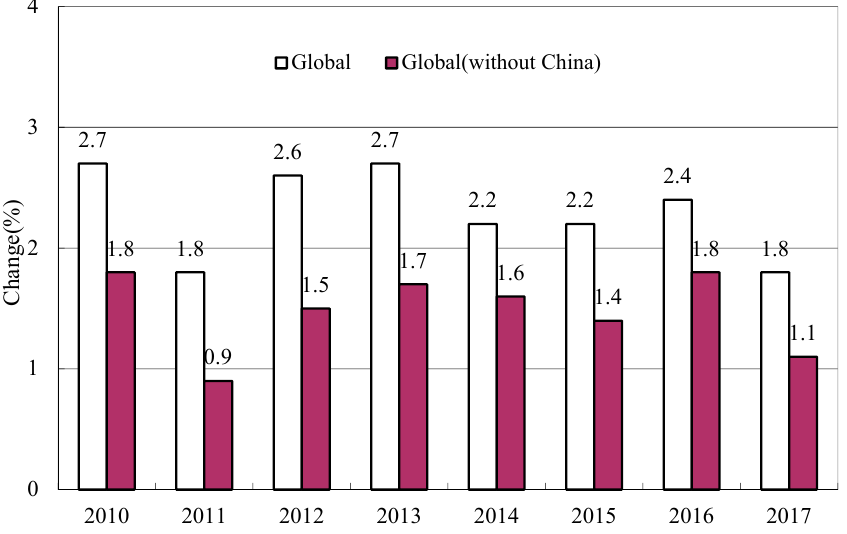
Figure 2. Annual average global real wage growth. [6].